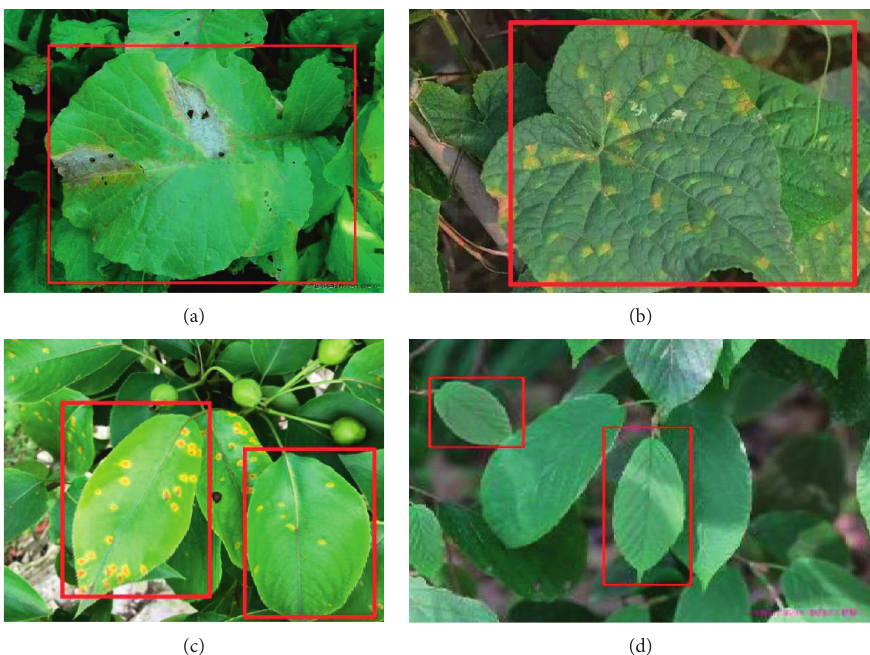
Figure 2: The result of leaf identification: (a) black rot disease; (b) bacteria plaque disease; (c) rust disease; (d) healthy